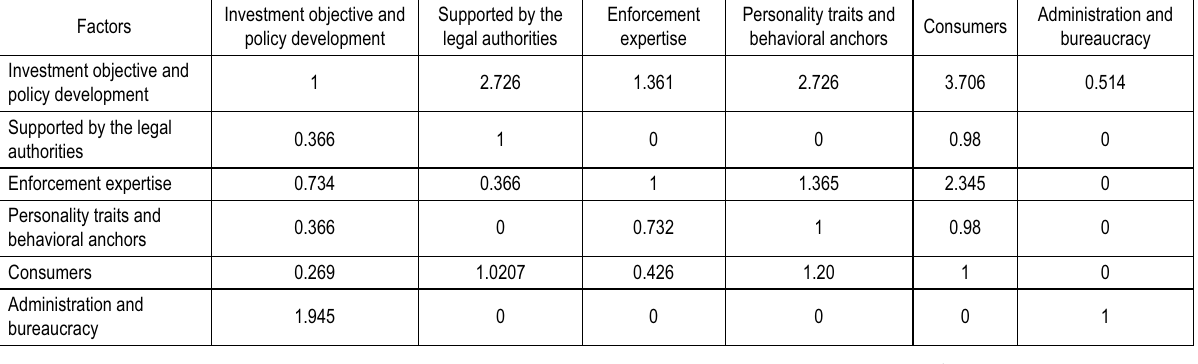
The priority indicators are shown in Table